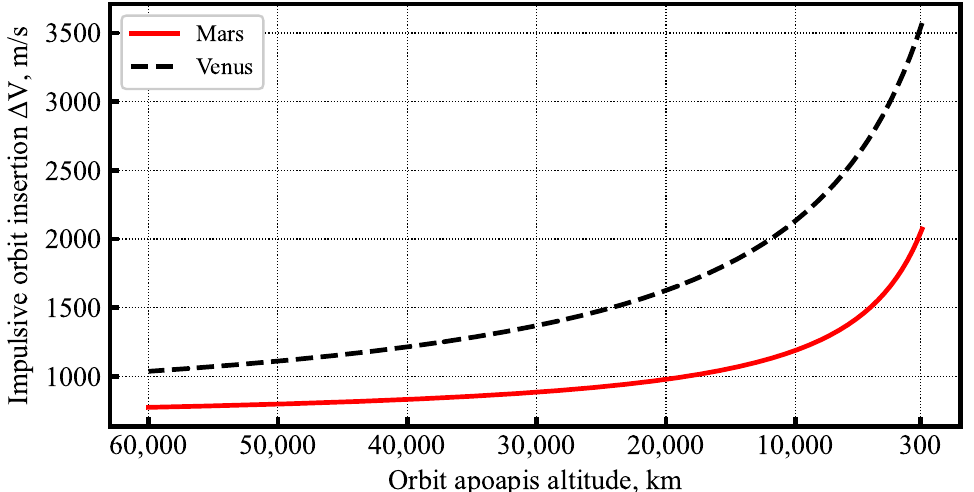
Figure 1. Orbit insertion ∆ V as a function of the apoapsis altitude at Mars and Venus from trajectories with V ∞ = 2.5 and 3.5 km/s, respectively, periapsis altitude = 200 km.